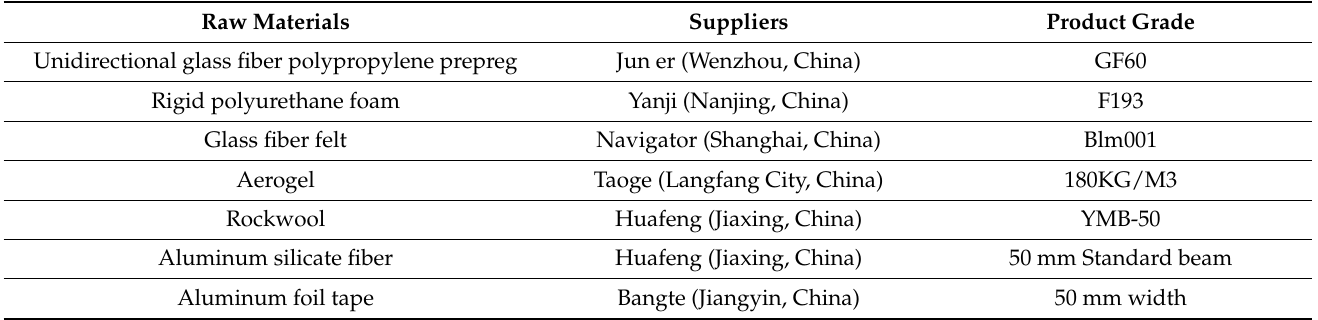
Table 1. Experimental materials.